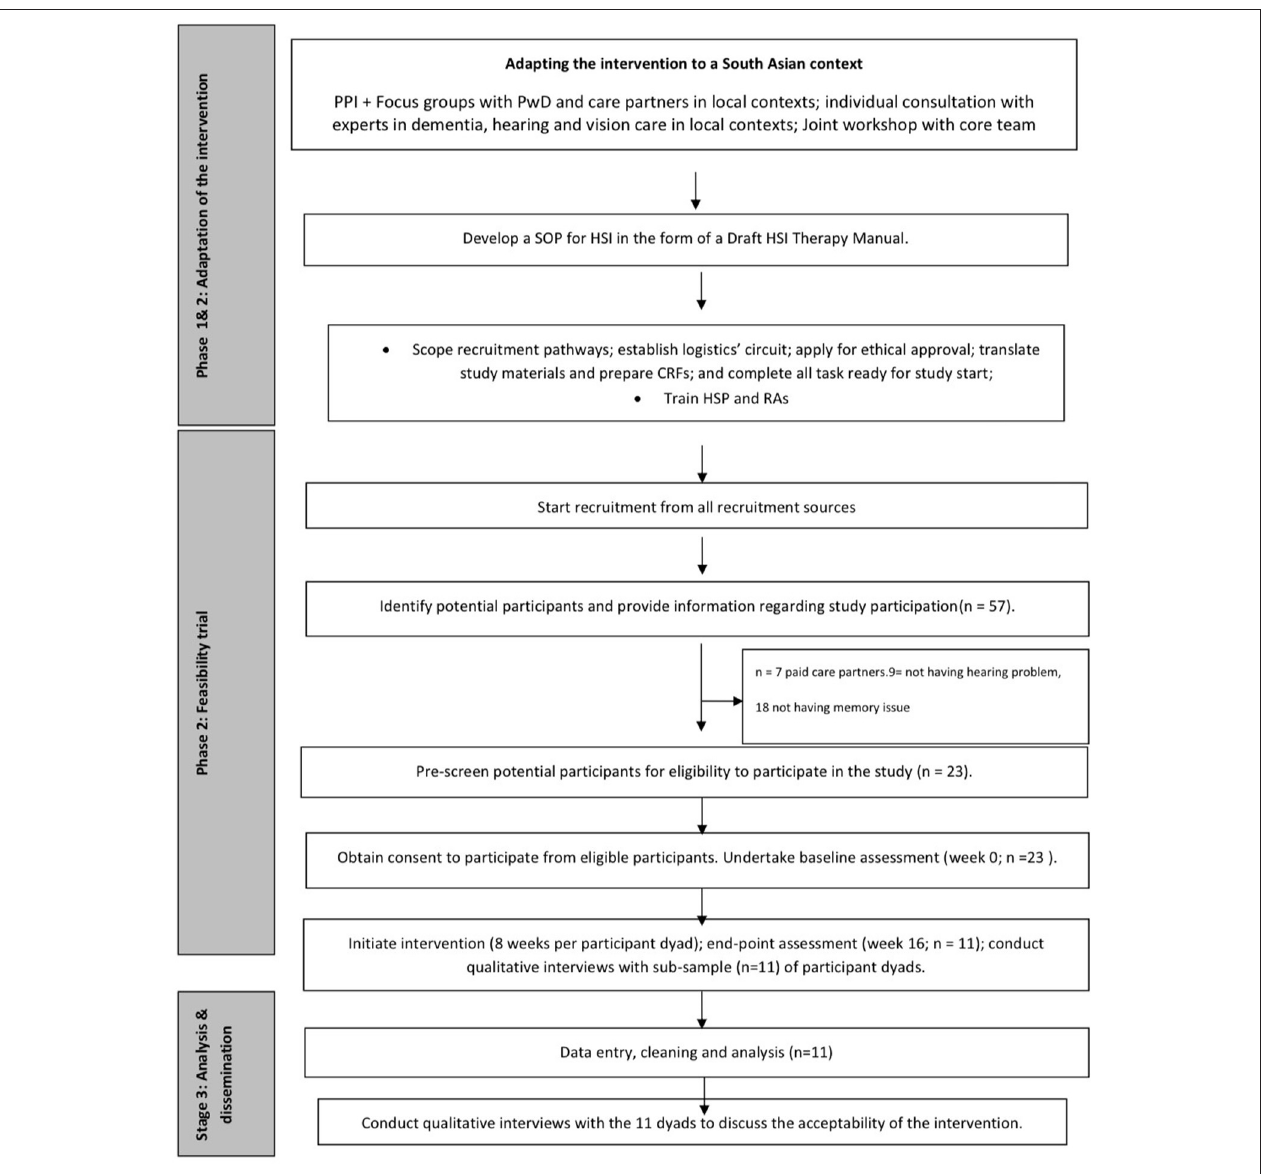
FIGURE 1 | Flowchart of steps in the SENSE-Cog Asia feasibility